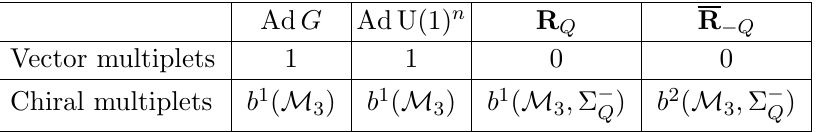
Table 2 . The 4d N = 1 matter content for a background given by a U(1) n valued Higgs bundle whose spectral cover is fully factored. Here (cid:6) (cid:0) to the function f Q . Note b 1 ( M 3 ) = b 2 ( M 3 ) and b 1 ( M 3 ; (cid:6) (cid:7)